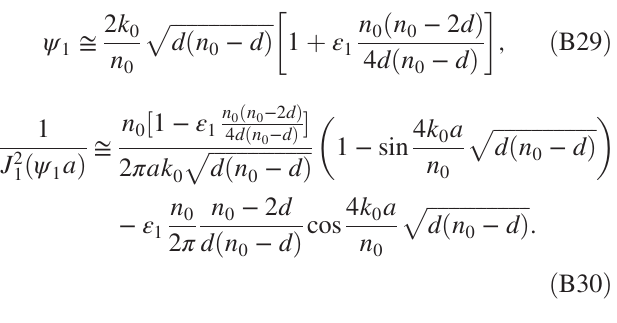
Figure 14(b) uses (B30) to plot the modulated oscillatory term ½ ϕ d J 2 1 ð ψ 1 a Þ(cid:2) − 1 , showing the clustering envelope over the oscillating